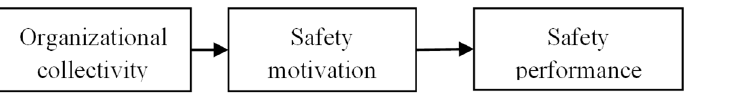
Figure 3. Hypothesized model of mediating effect of SMO between OC and SP.